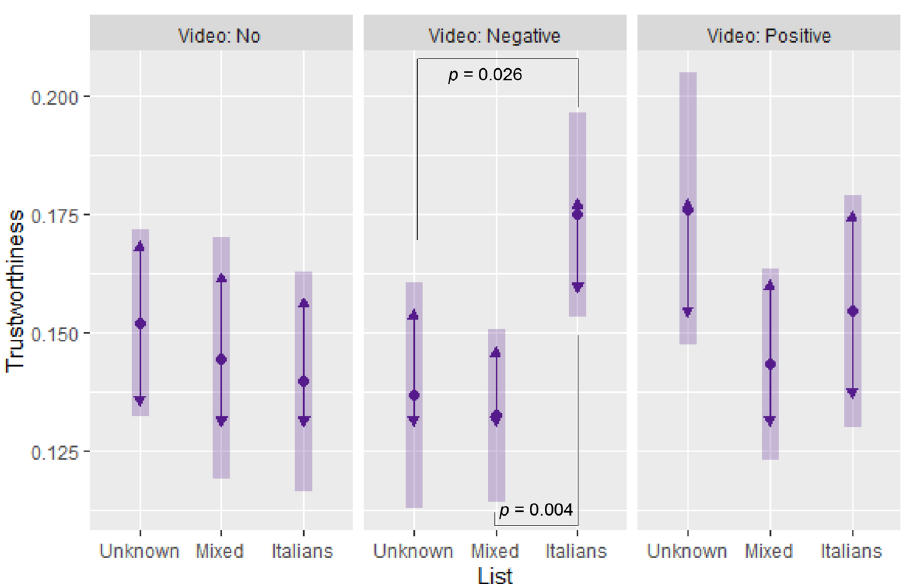
Figure 3. The effects of media portrayals of immigrants on trustworthiness (Study 2). Estimated marginal means (range 0–1) of trustworthiness by video and list conditions (Tukey adjustment for contrasts; bars: 95% confidence intervals; non-overlapping arrows: statistically significant pairwise comparison, p < 0.05). Trustworthiness: money returned over received in trust game, averaged across all hypothetical trustor’s transfers. Sample: Study 2